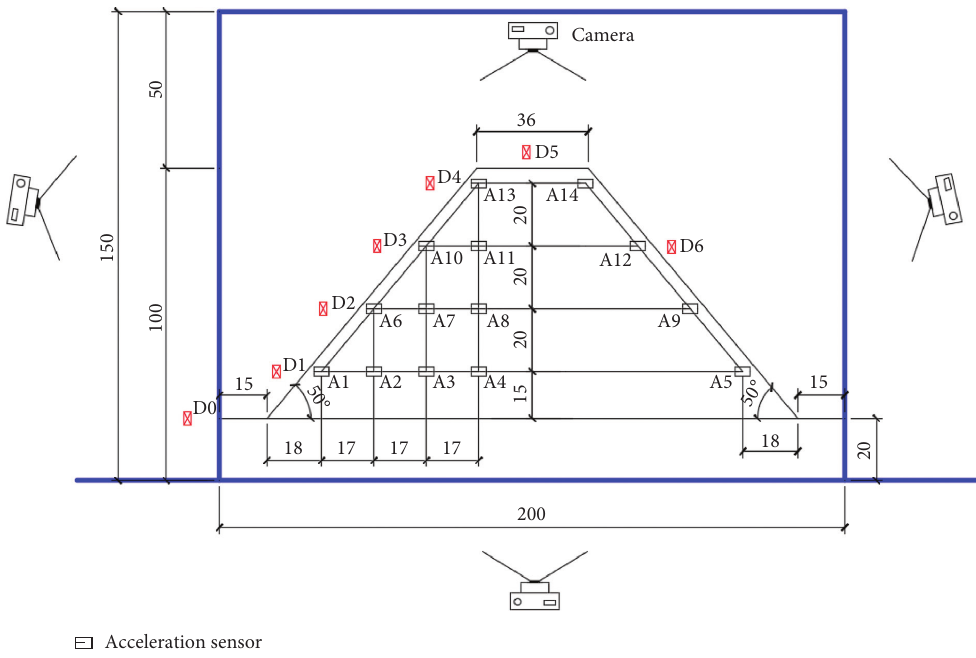
Figure 3: Layout of monitoring